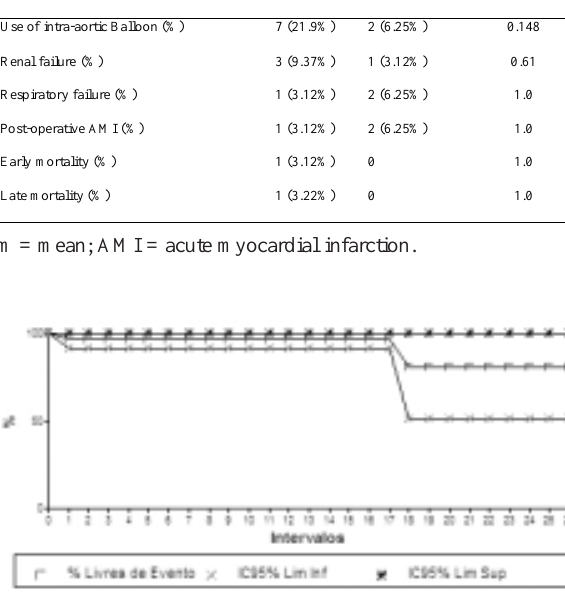
Fig. 2 – Actuarial survival curve of endarterectomy patients over 26